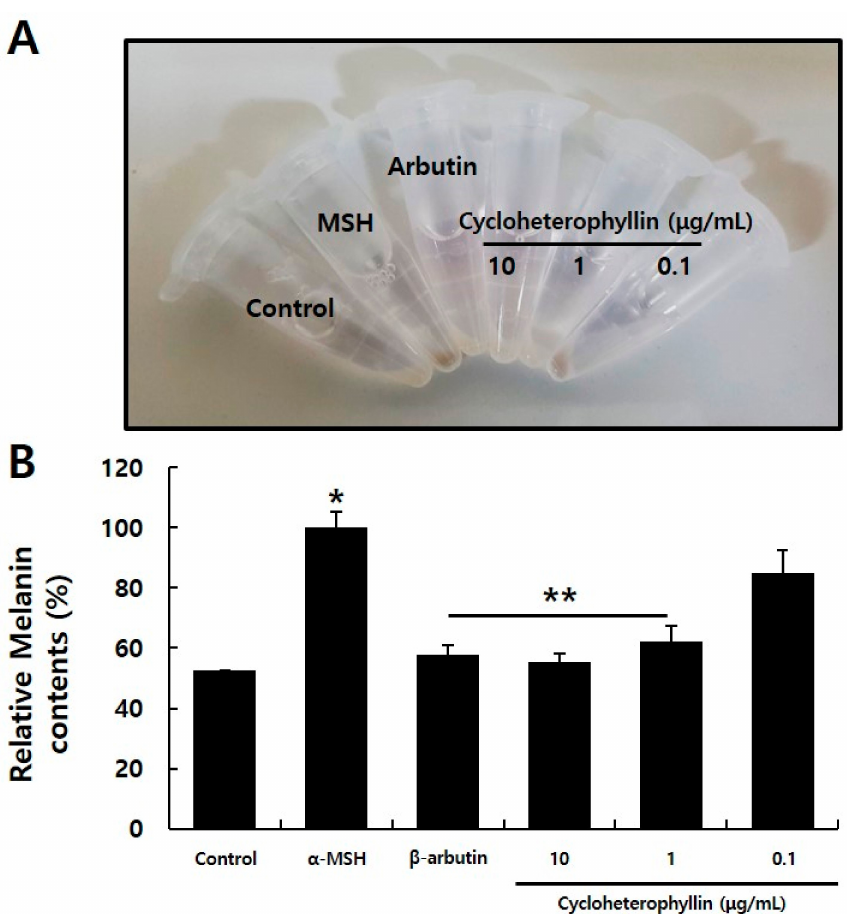
Figure 4. Melanin synthesis inhibition of cycloheterophyllin on B16F10 cells. Representative image of B16F10 cells after cycloheterophyllin treatment ( A ). Treated cells were lysed with 1 N NaOH and absorbance was measured at 405 nm ( B ). Results are expressed as means ± S.D. of three independent experiments. * compared to control, p < 0.05. ** compared to α -MSH-treated condition, p < 0.05.